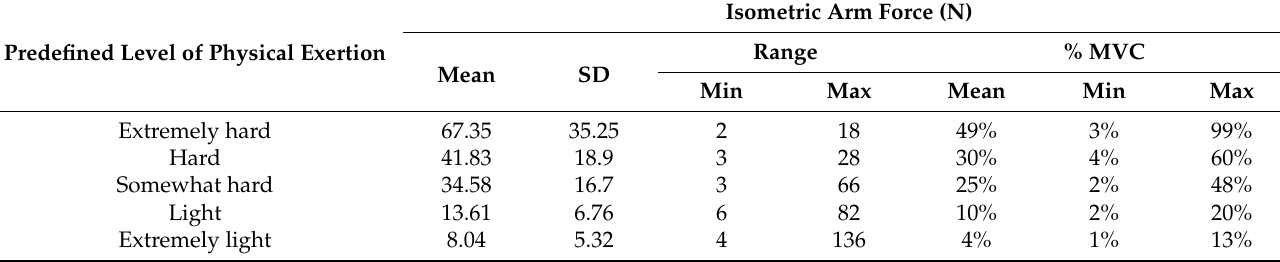
Table 2. Statistics of isometric arm exertion forces, including the mean, standard deviation (SD), range, and percentage of maximum voluntary contraction (MVC) at different physical exertion levels.